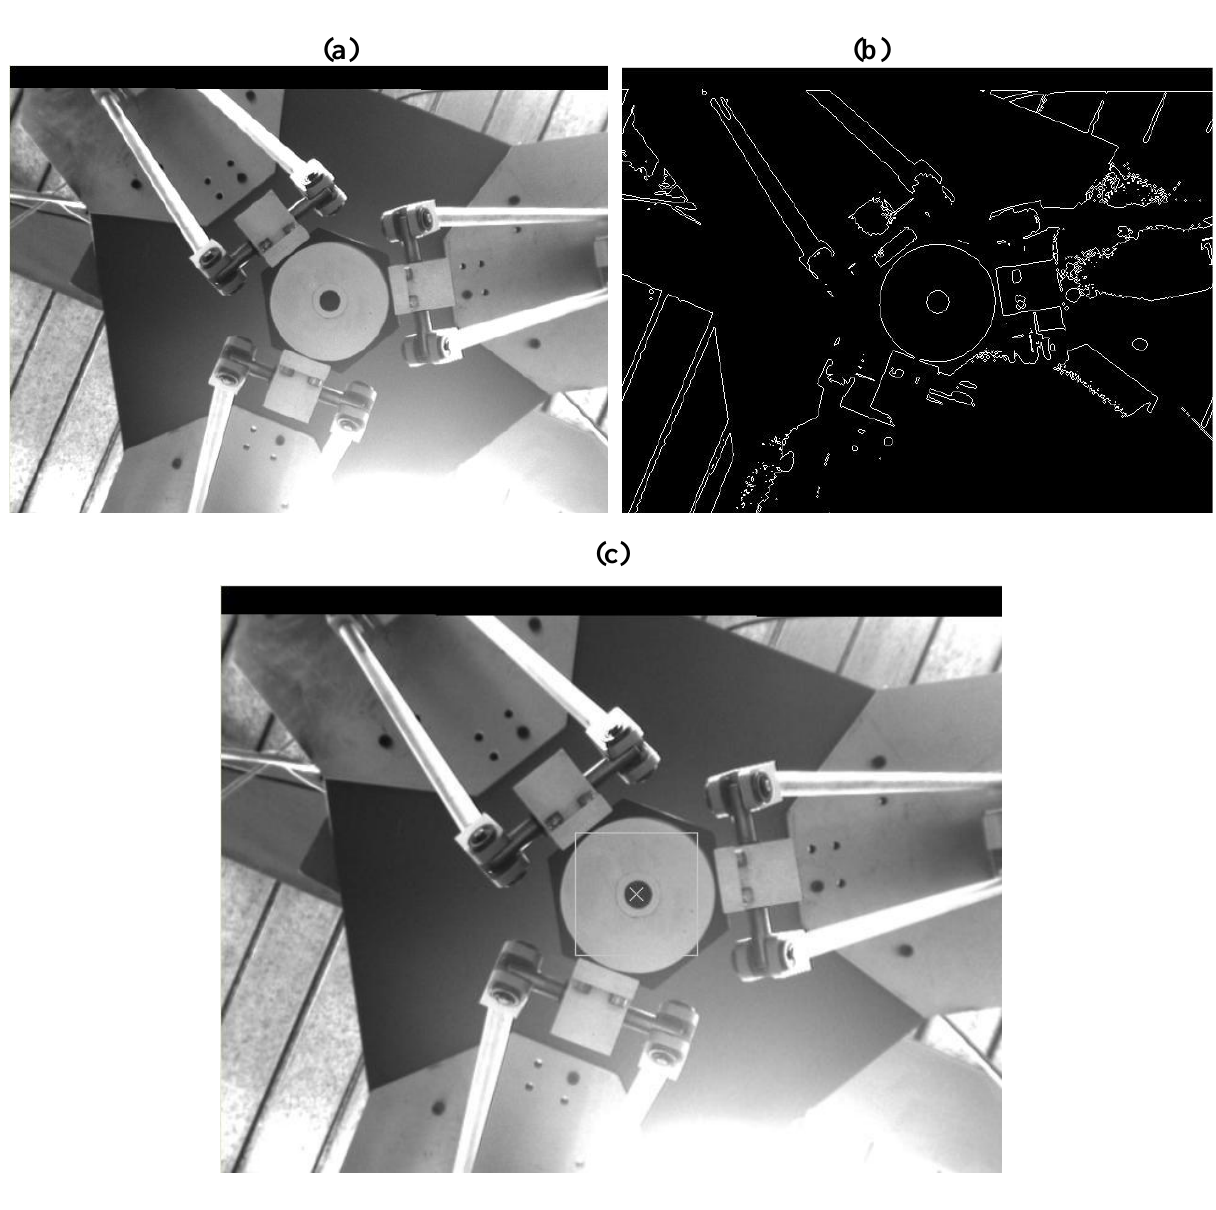
Figure 9. The target detection results: (a) The end-effector of robot arm, (b) After Laplacian operator of Figure 5(a), (c) Target detected and marked in a white